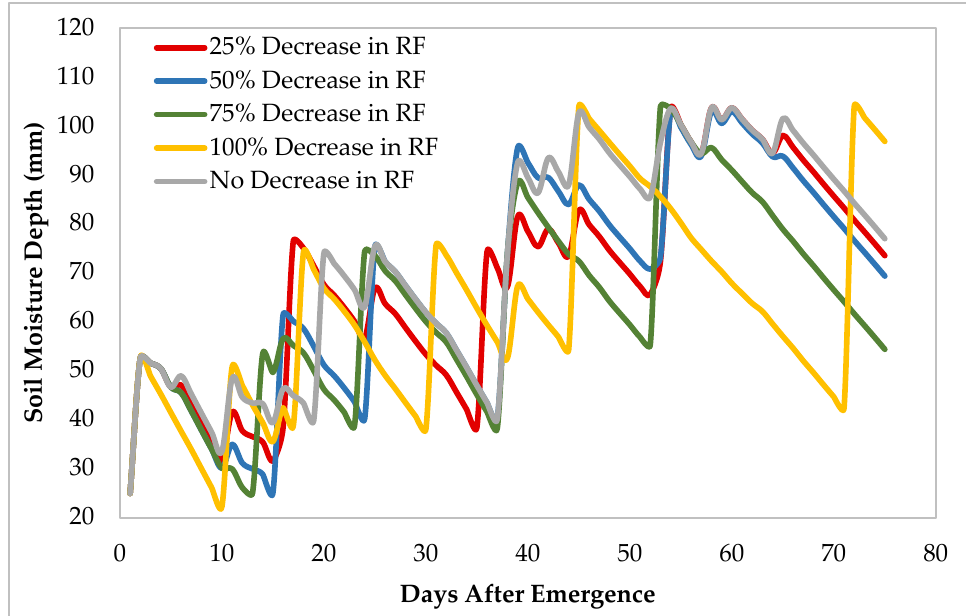
Figure 8. Model simulations under decreased rainfall scenarios.